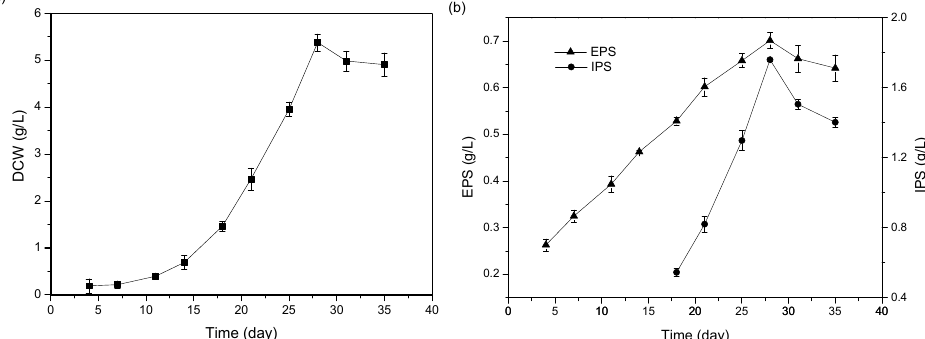
Figure 5. Time profile of T. borchii ( a ) enhanced dry cell weight; ( b ) polysaccharides production under submerged fermentation.